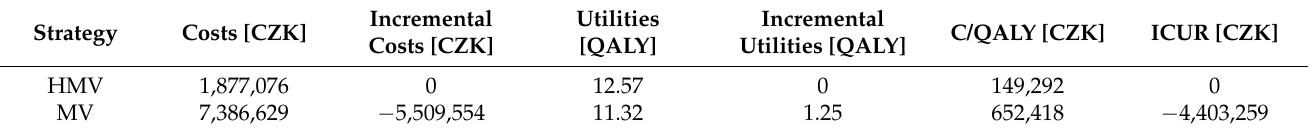
Table 7. Cost–utility